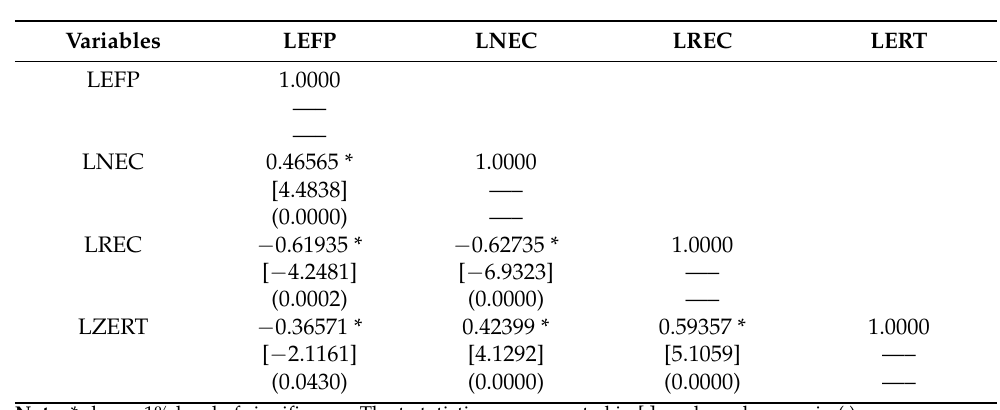
Figure 2. Average trend analysis of the study variables (e.g., EFP, NEC, REC, and ERT). Table 4. Pearson correlation